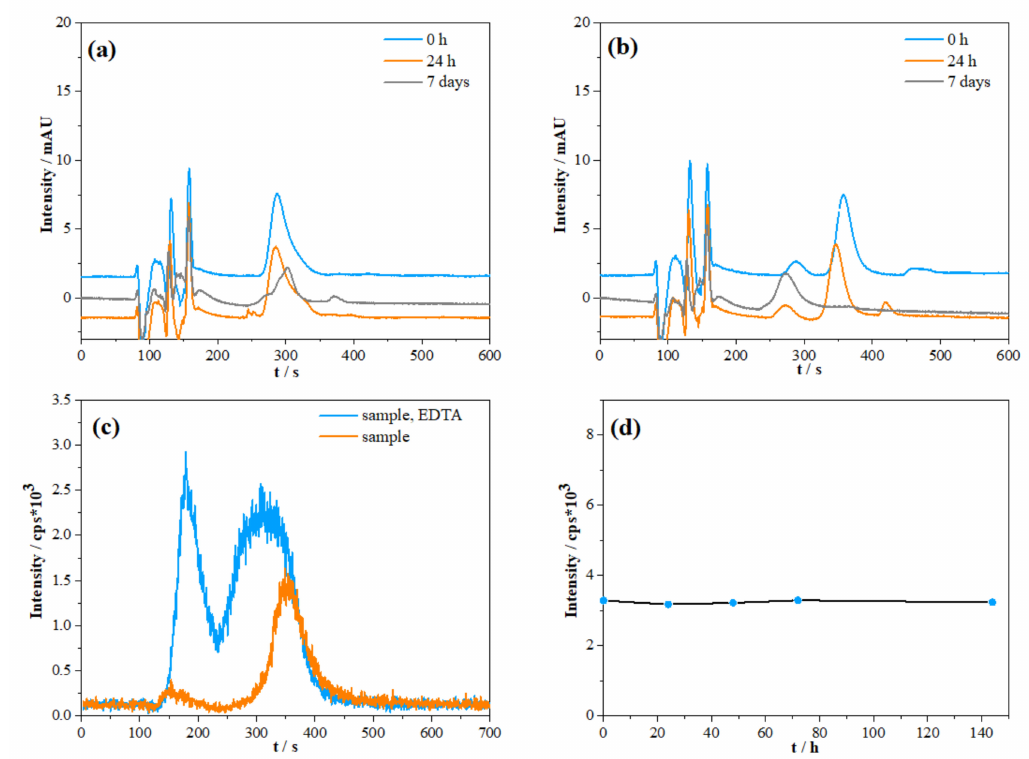
Figure 2. Temporal evolution of IC-UV/VIS chromatograms of V(V) (1 µ mol L –1 ) and EDTA (3 mmol L − 1 ) in two solutions of different pH values: ( a ) pH of 7 and ( b ) 2 (blue curve: solution measured right after preparation; orange curve: solution measured after 24 h; grey curve: solution measured after 7 days). ( c ) Comparison of different approaches to sample storage measured using IC–ICP–MS (orange curve: chromatogram of a sample filtered on-site and stored at +4 ◦ C; blue curve: chromatogram of a same sample containing ligand (3 mmol L –1 EDTA) added on-site, after filtration. ( d ) Stability of V(V) (40 nmol L − 1 ) spiked in natural sample of the Krka River estuary during the time period of 144